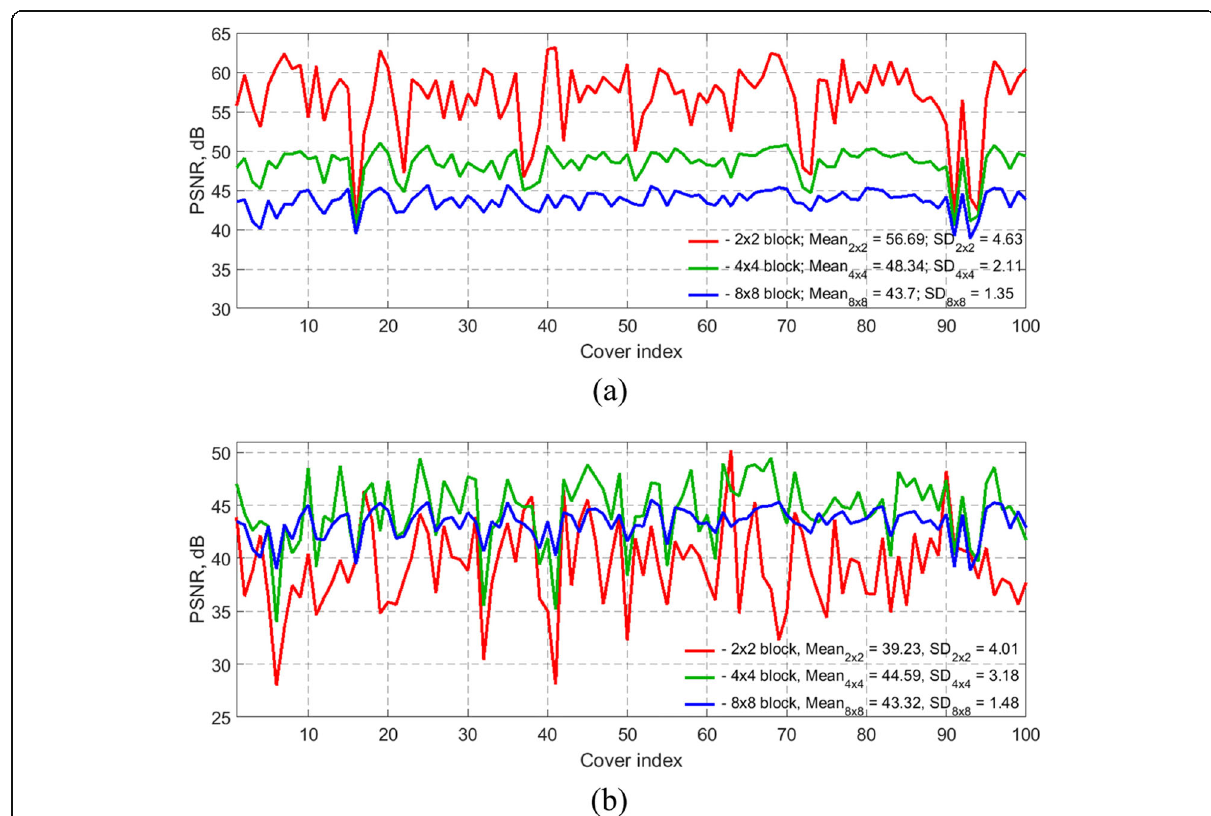
Fig. 5 a PSNR values for the differently sized local blocks before embedding in the DCT domain and ( b ) after embedding in the DCT